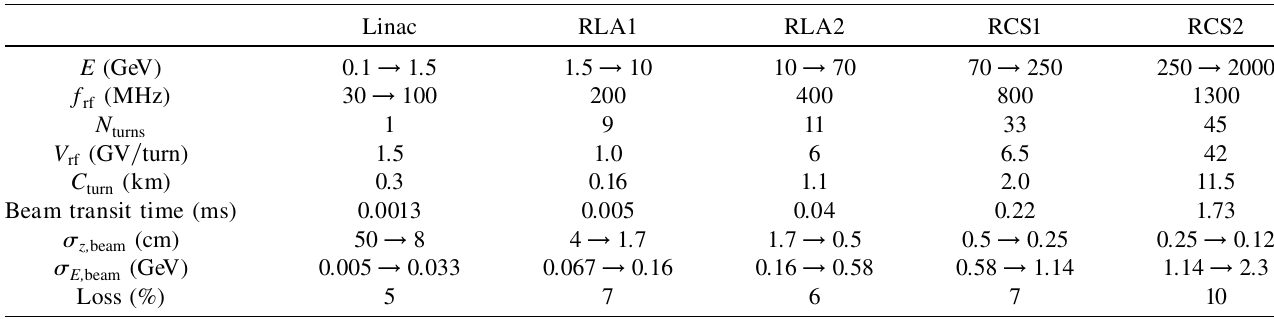
TABLE XV. Parameters of acceleration for a 4 TeV muon collider. Linac